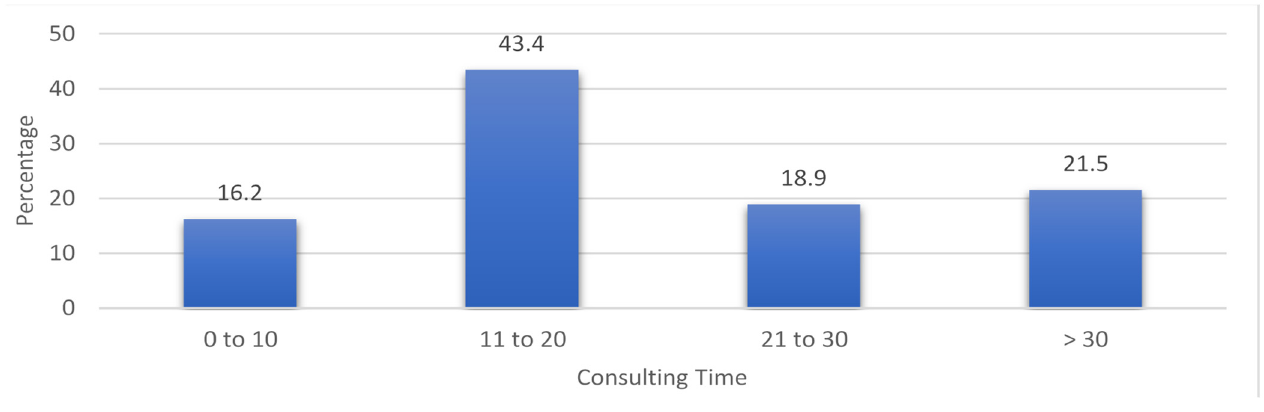
Figure 3. Percentage of consulting time.